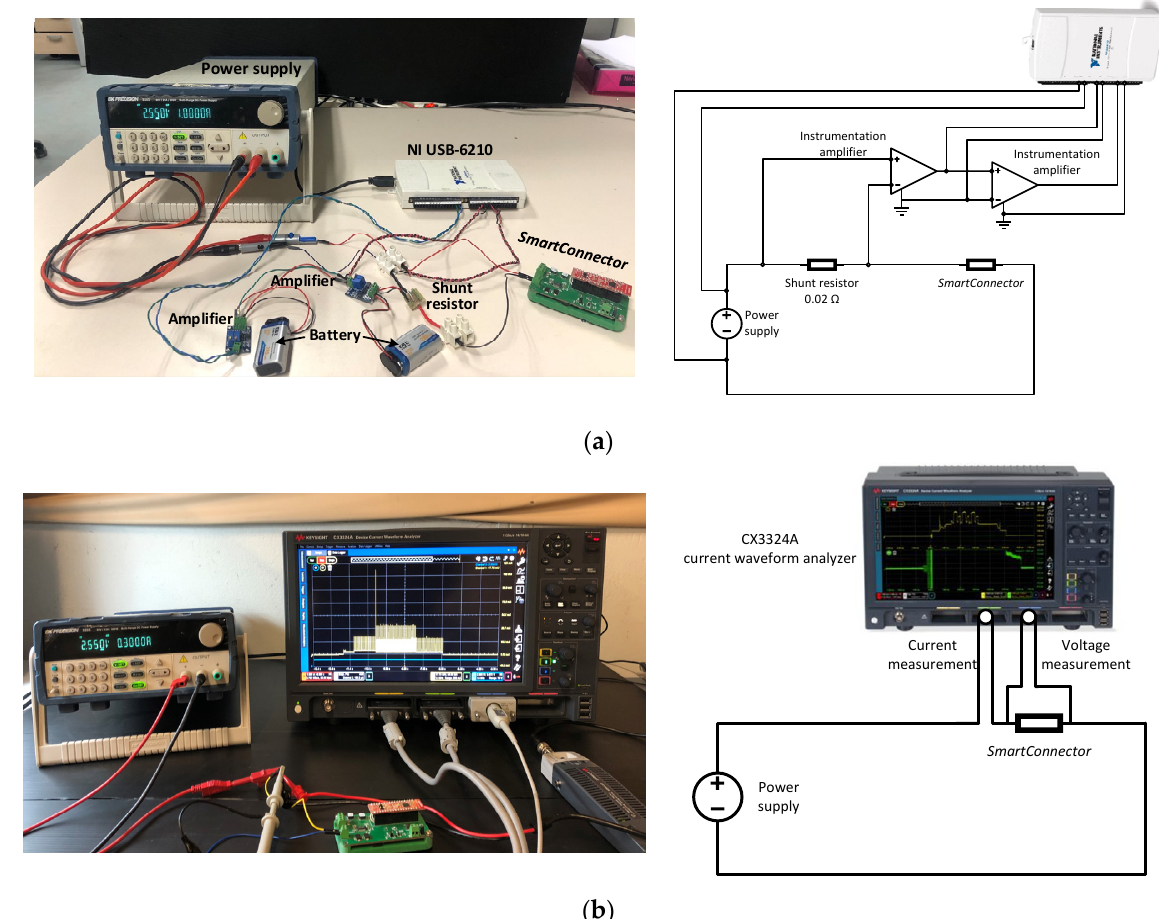
Figure 6. Experimental setup to determine the energy consumption of the IoT device. ( a ) Lab-design system. ( b ) CX3324A current waveform analyzer.